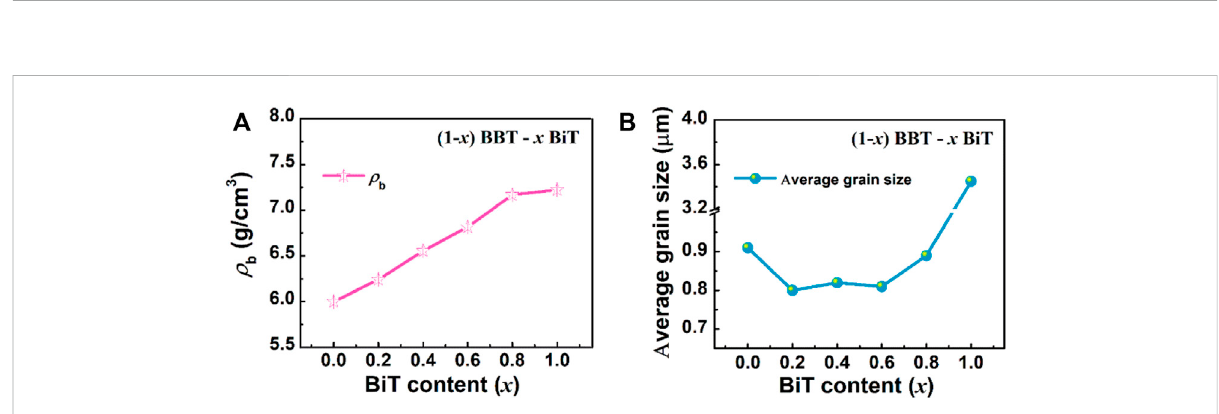
FIGURE 3 Evolutions in bulk density ( ρ b ) and average grain size as x value increase in (1- x ) BBT - x BiT ceramics: (A) bulk density ( ρ b ), and (B) average grain